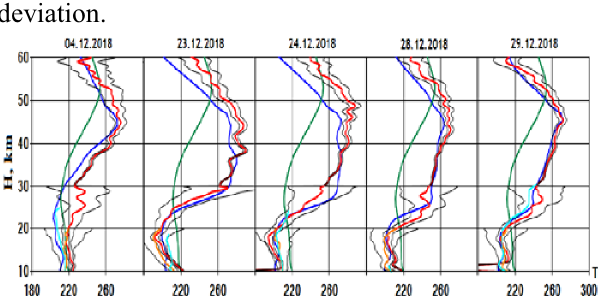
Fig. 8. Lidar and satellite observations of the dynamics of stratospheric warming during winter 2018/2019.